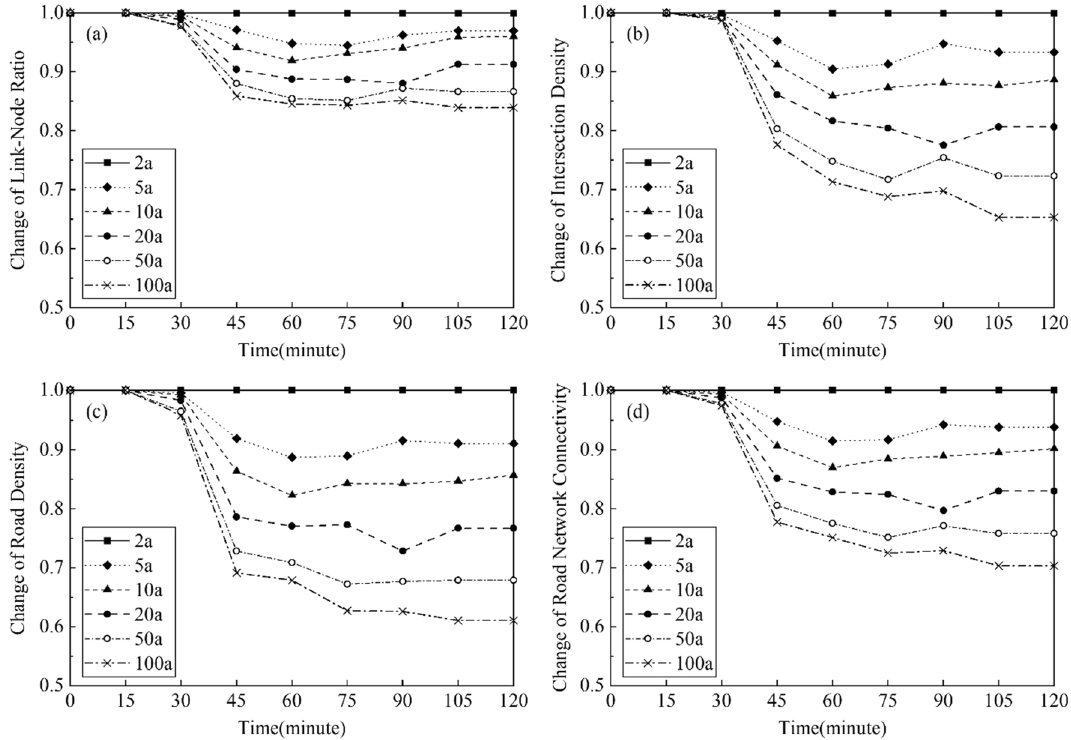
Figure 13. Changes of road connectivity in the case area: ( a ) Link-Node Ratio; ( b ) Intersection Density; ( c ) Road Density; ( d ) Road Network Connectivity. This graph was generated with OriginPro 2021 (Learning Edition)(https:// www. origi nlab. com/).